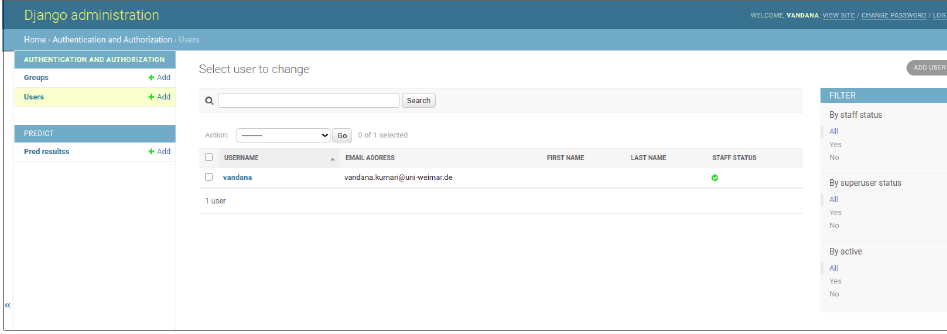
Figure 12. Django admin page.